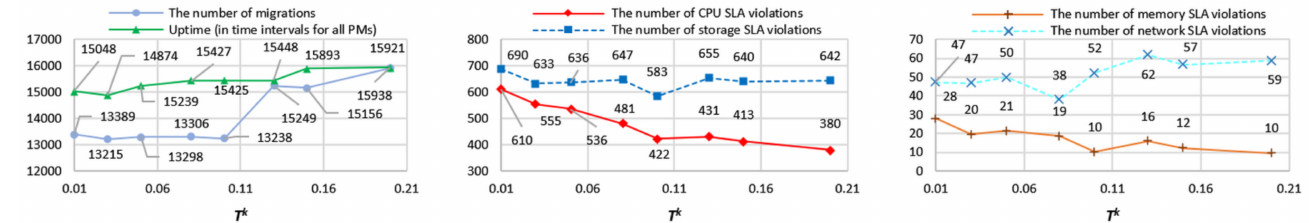
Figure 5. The effect of T k on the quality metrics for power consumption minimization. Figure 6 shows the effect of D k on the quality metrics with the fixed values L k = 0.35 and T k = 0.03. D k takes values as shown in Table 2. The optimal value in terms of power consumption is D k = 0.9 (Figure 6) since the minimum uptime of PMs is observed. The values of T k and D k are fixed when determining the optimal value of the parameter Q k .